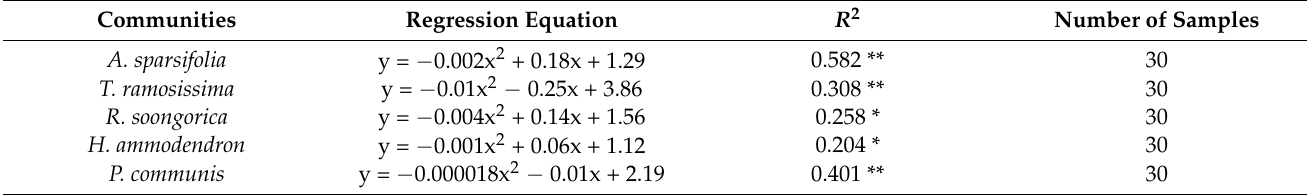
Table 5. Regression analysis of soil organic carbon (SOC) and fine root biomass at 0–100 cm from June to